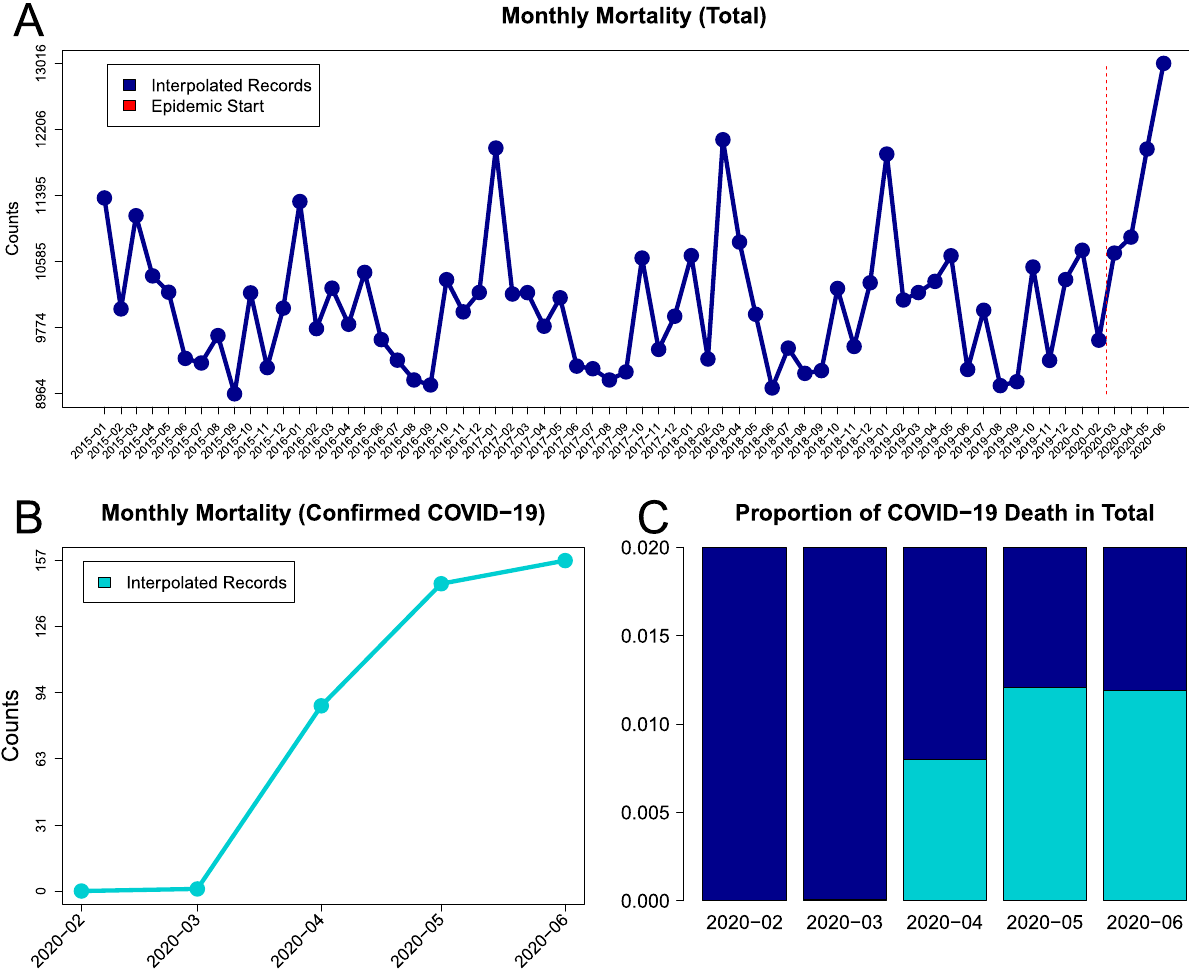
Figure 1. The visual summaries of the raw data for overall and COVID-19-related mortality: ( A ) Total monthly mortality counts joined by a linear interpolator. The start of the epidemic is marked with a vertical red bar. ( B ) COVID-19-related monthly mortality counts joined by a linear interpolator. ( C ) Monthly proportions of COVID-19-related mortality among the total